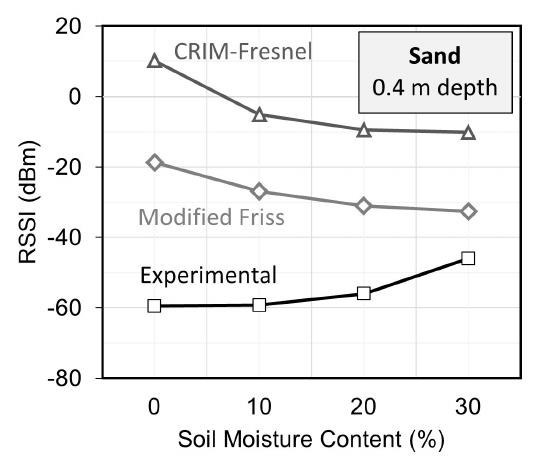
Figure 6. LoRa signal strength in sand with different moisture content at depth of 0.4m